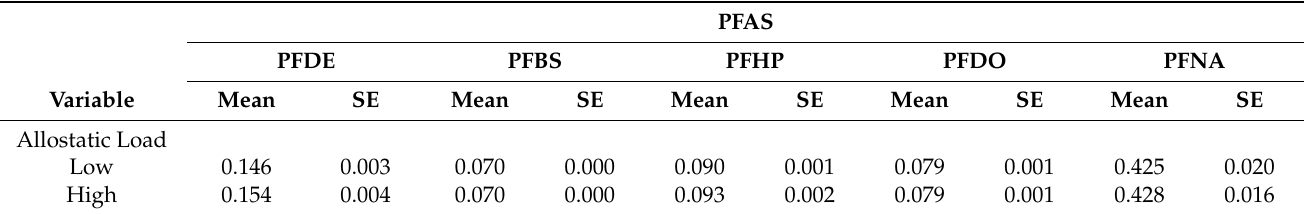
Table 3. Summary differences in participants’ serum PFAS (PFDE, PFBS, PFHP, PFDO, PFNA) concentrations (ng/mL) by Allostatic Load. PFAS PFDE PFBS PFHP PFDO PFNA